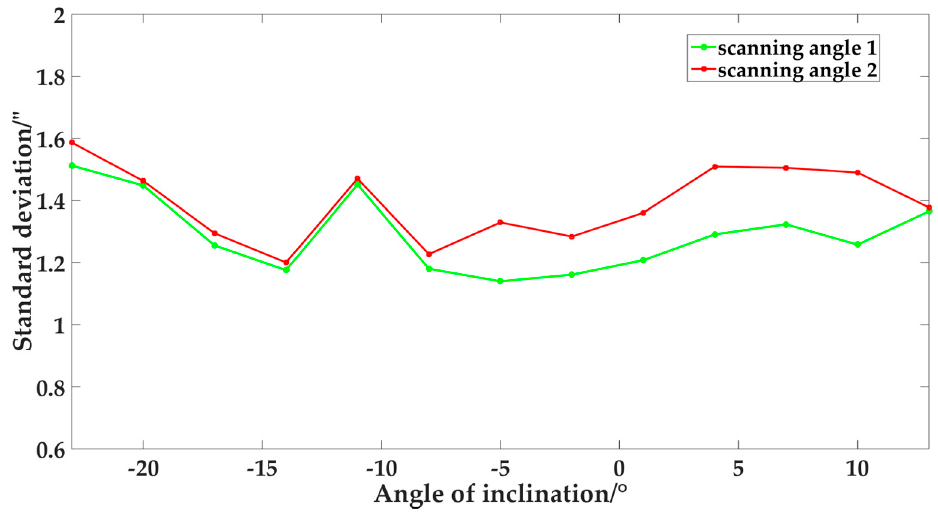
Figure 5. The results of the angle-measurement performance tests.